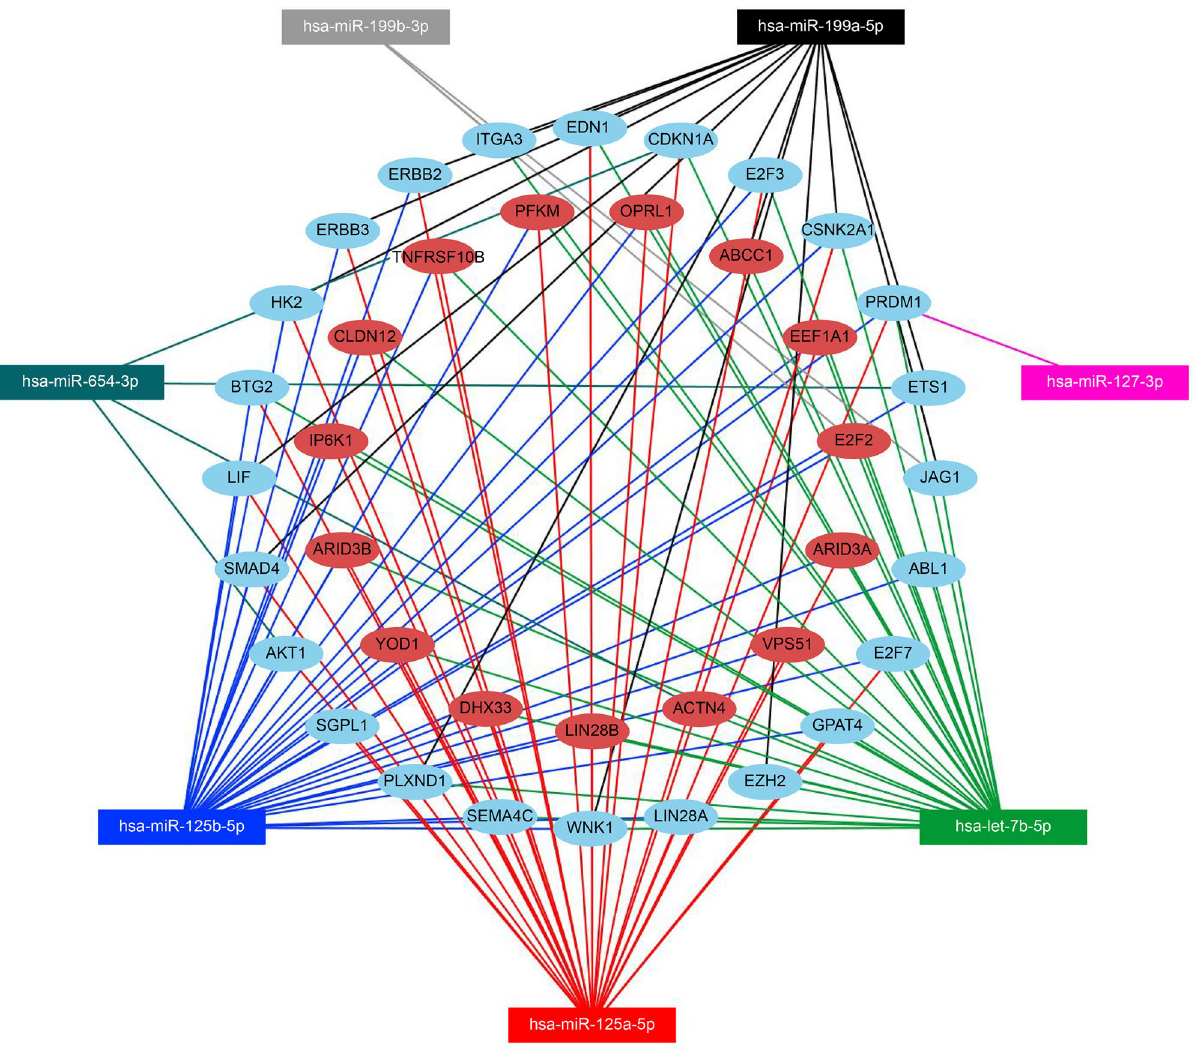
Figure 2. miRnet interactome network for the high-expression, upregulated miRNAs in the KS sample subset. Interaction between highly expressed upregulated miRNAs, hsa-miR-654-3p, hsa-miR-127-3p, hsa-let-7b-5p, hsa-miR-199a-5p, hsa-miR-125a-5p, hsa-miR-125b-5p, and hsa-miR-199b-3p (squares), in the Klinefelter sample tissues with target genes (blue and red dots). Blue dots represent genes involved in different cell functions: differentiation, cell proliferation, system development, and